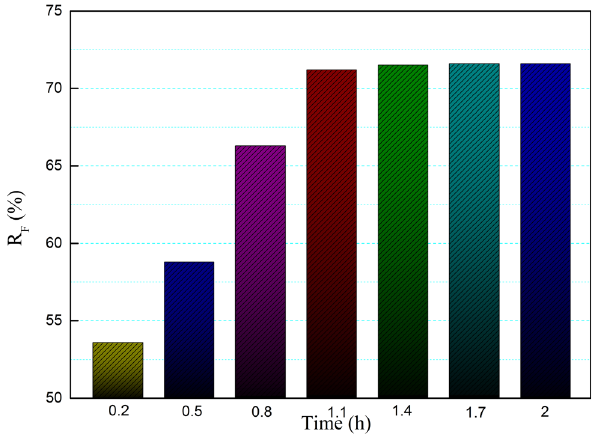
Figure 6: E ff ect of adsorption time on R F